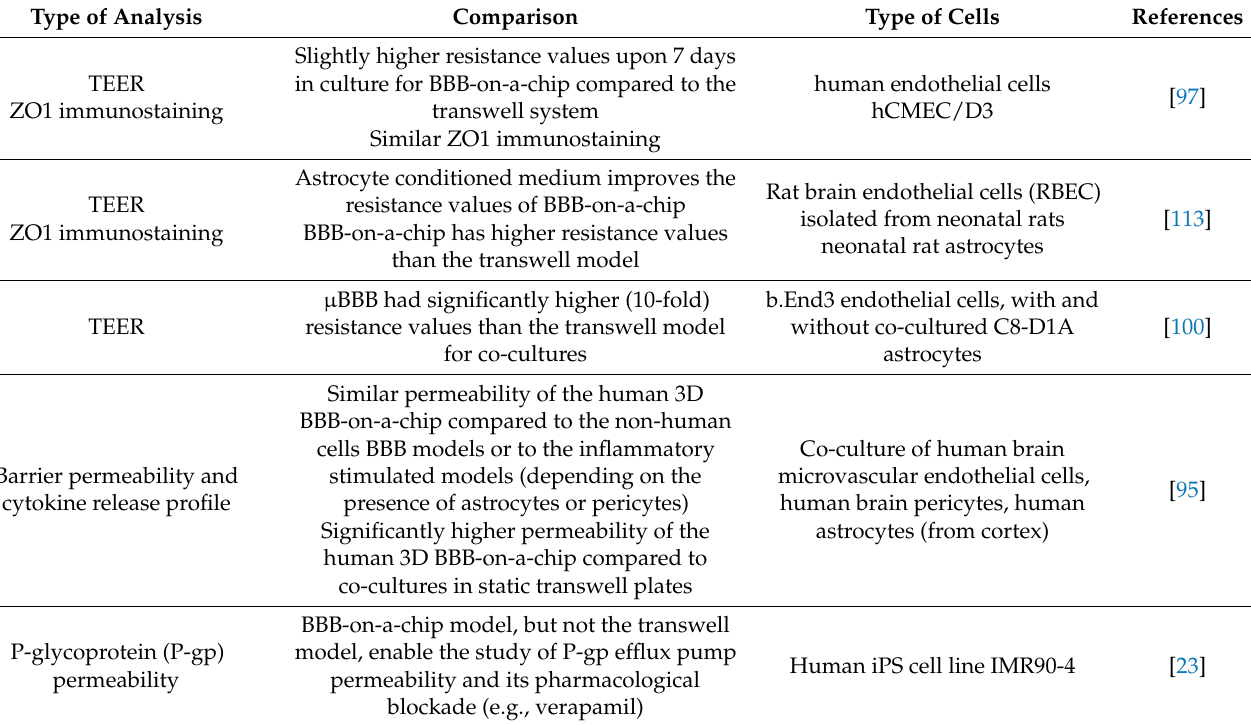
Table 5. Comparison between the BBB-on-a-chip and BBB in the transwell system. Type of Analysis Comparison Type of